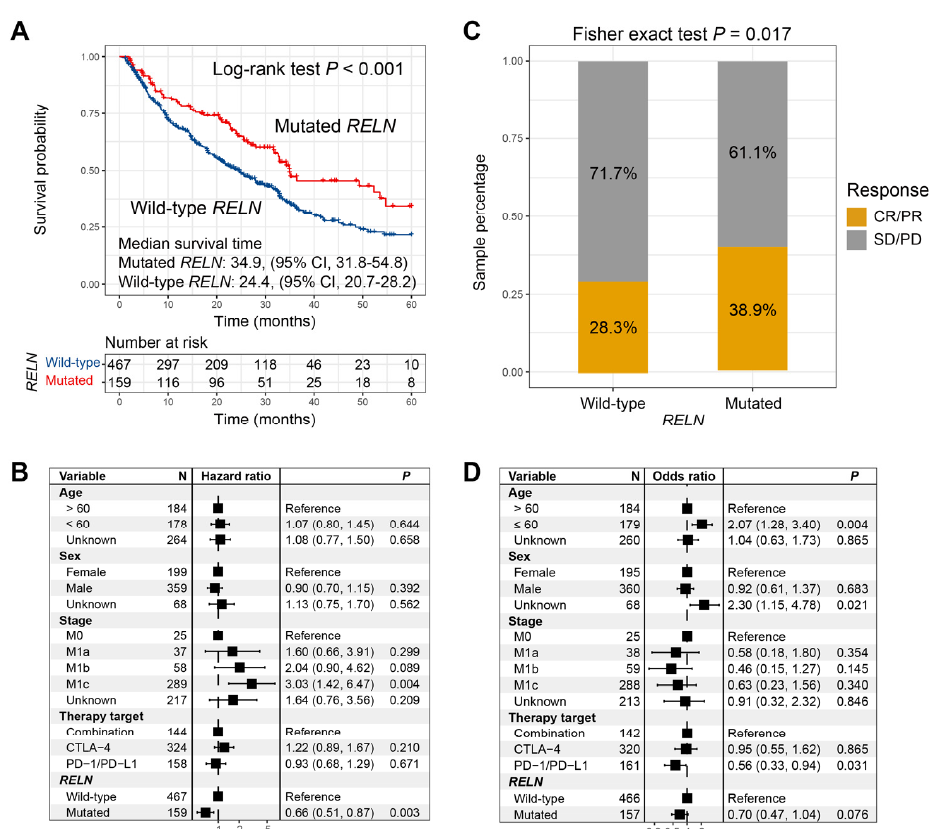
Figure 2. ICI treatment prognosis and response rate analyses of RELN mutations in melanoma. ( A ) Survival curves of RELN -mutated and wild-type patients. ( B ) Multivariable Cox regression analysis of RELN mutations was performed with clinical confounders taken into consideration. ( C ) Bar plot representation of ICI response rates of RELN -mutated and wild-type patients. ( D ) Multivariable logistic regression analysis of RELN mutations was achieved.